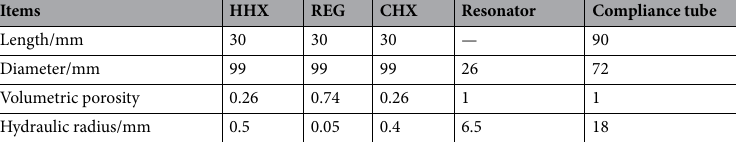
Table 1. Dimensions of the main parts of LTAPMs.